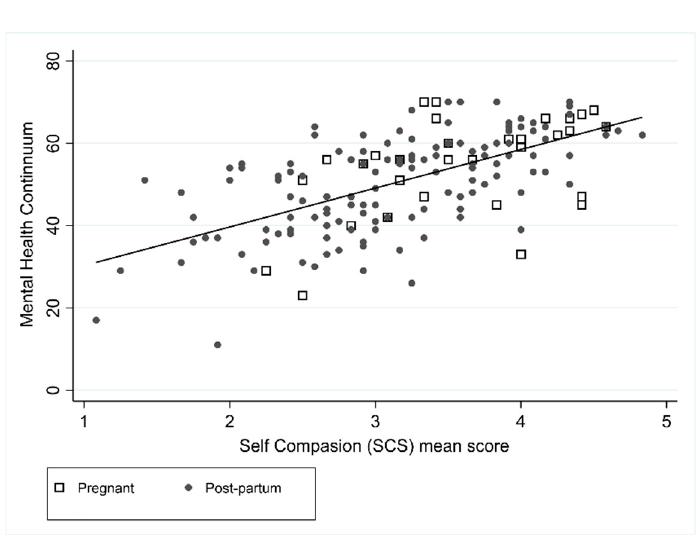
Figure 1. Association between MHC and SCS.